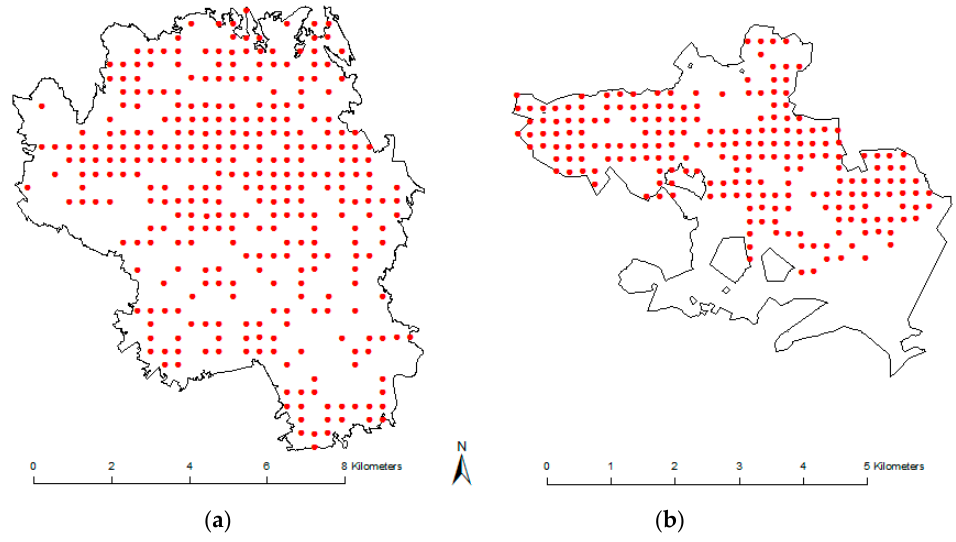
Figure 2. The spatial arrangement of the field inventoried plots at the two test sites, Krycklan ( a ) and Remningstorp ( b ).